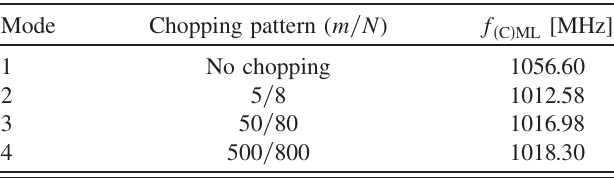
TABLE X. Chopping patterns and the used resonance frequen- cies for dipole modes in both linac